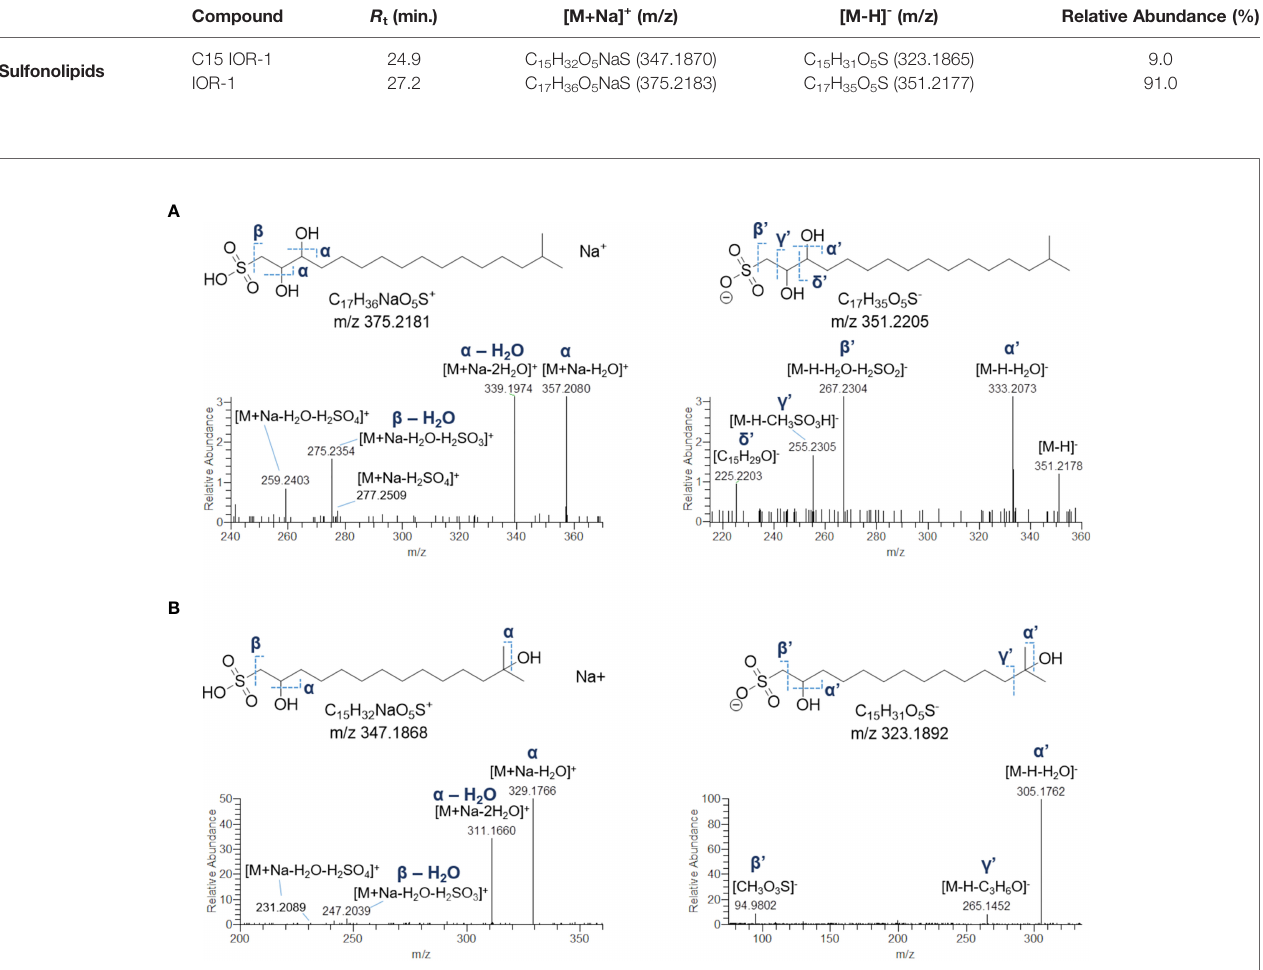
TABLE 5 | Sulfonolipids identi fi ed in the organic extract from Botrylloides niger . Compound